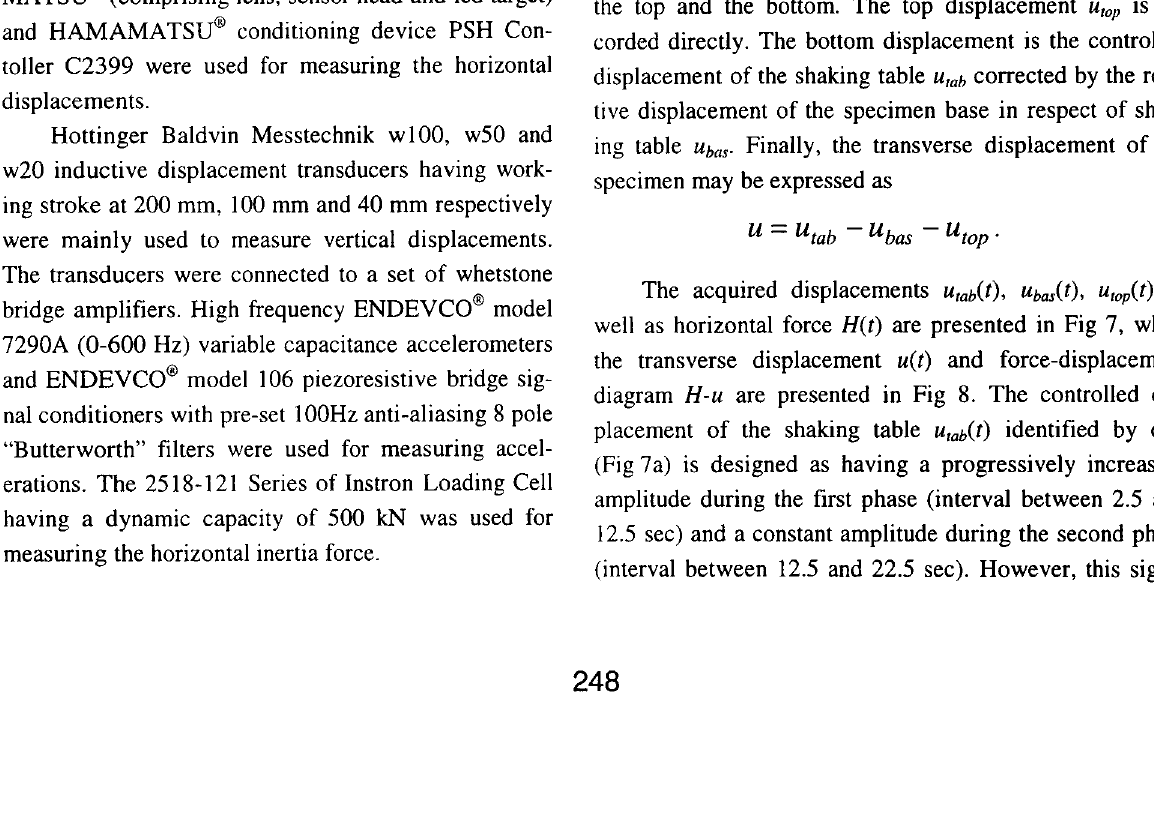
Fig 5. Location of displacement gauges: a) side E, b) sideS, c) side E, d) orientation of sides of the speci men 7 cannels were to acquire the accelerations, using accelerometers. Two devices alt and a2t measured horizontal transverse (in plane) accelerations while another two longitudinal accelerations of the shaking table. Devices am1-L and am1-T control acceleration of the top point of the column in plane and out of plane directions. Device At-M measured the external inertia mass acceleration. The horizontal force was measured by a loading cell HL equipped as part of the connection 20d.